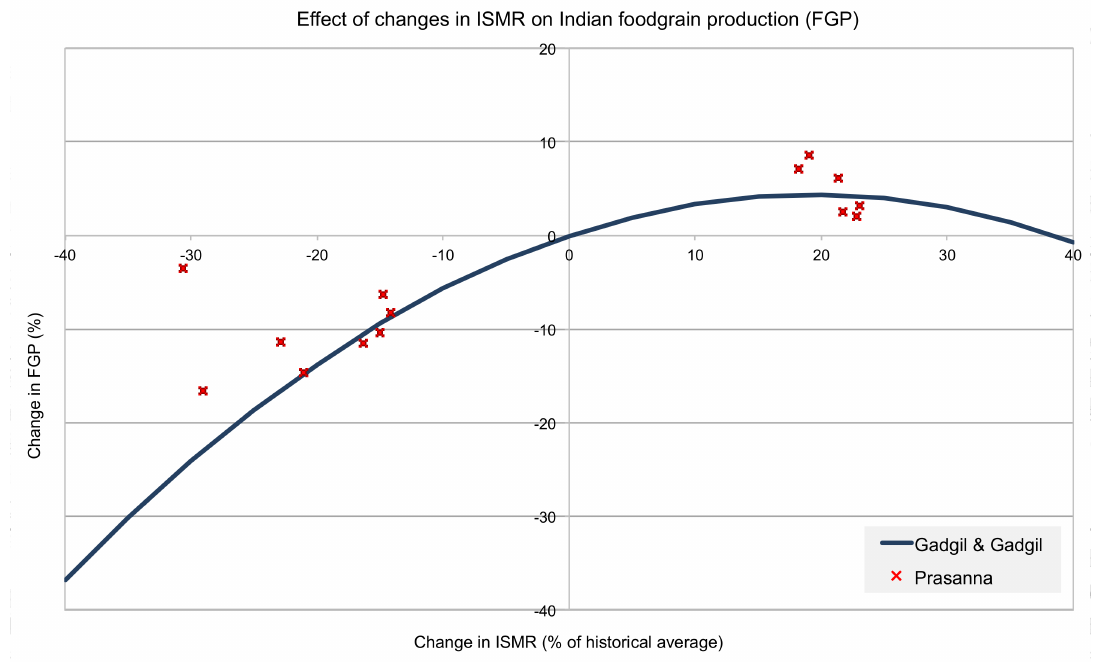
Figure 3. Relationship between ISMR and Indian FGP. The blue line is redrawn from Gadgil and Gadgil [15]. The additional data points are from Prasanna [11], de-indexed using the average total FGP for the years 1966–2007 and from government statistics